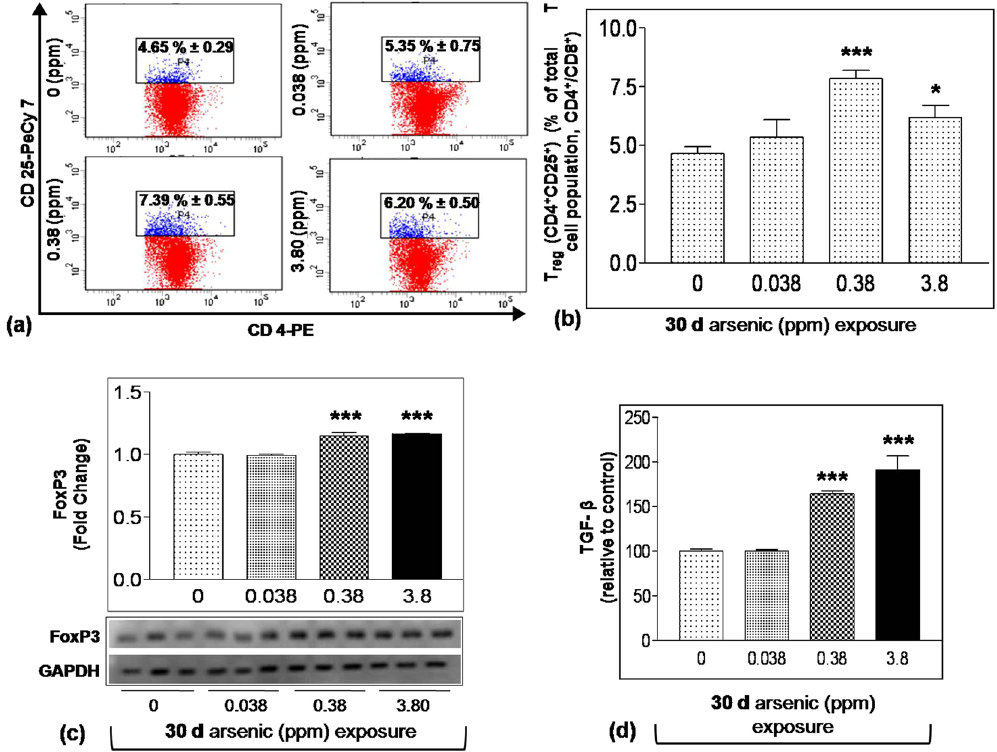
Figure 5. Effect of arsenic exposure on T reg cell. Splenocytes isolated from mice treated with arsenic (0.00, 0.038, 0.38 and 3.8 ppm) orally for 30 days were processed to isolate CD4 + and CD8 + T cells using CD4 and CD8 specific magnetic particles by positive selection. Purity of splenic T cells was 85 to 90%. Isolated splenic T cells were stained with PE conjugated CD4, PerCP conjugated CD8 and PeCy7 conjugated CD25 antibody for 1 h at 37 °C. PE stained CD4 + T cells were gated for CD25 + cells. Each representative dot plot (a) and bar graph (b) reflects percent population of CD4 + CD25 + T cells in total parent T cell population. (c) Representative western blot and densitometric analysis showing level of FoxP3 in spleen dissected from each treatment group. (d) Levels of TGF- β in splenocyte culture supernatants expressed as percent of control. Values are mean ± S.E. (n = 3-5 per group). * p < 0.05, ** p < 0.01 and *** p < 0.001 compared to control. The original full-length western blots for FoxP3 and GAPDH are provided in supplementary information sheet in Fig.